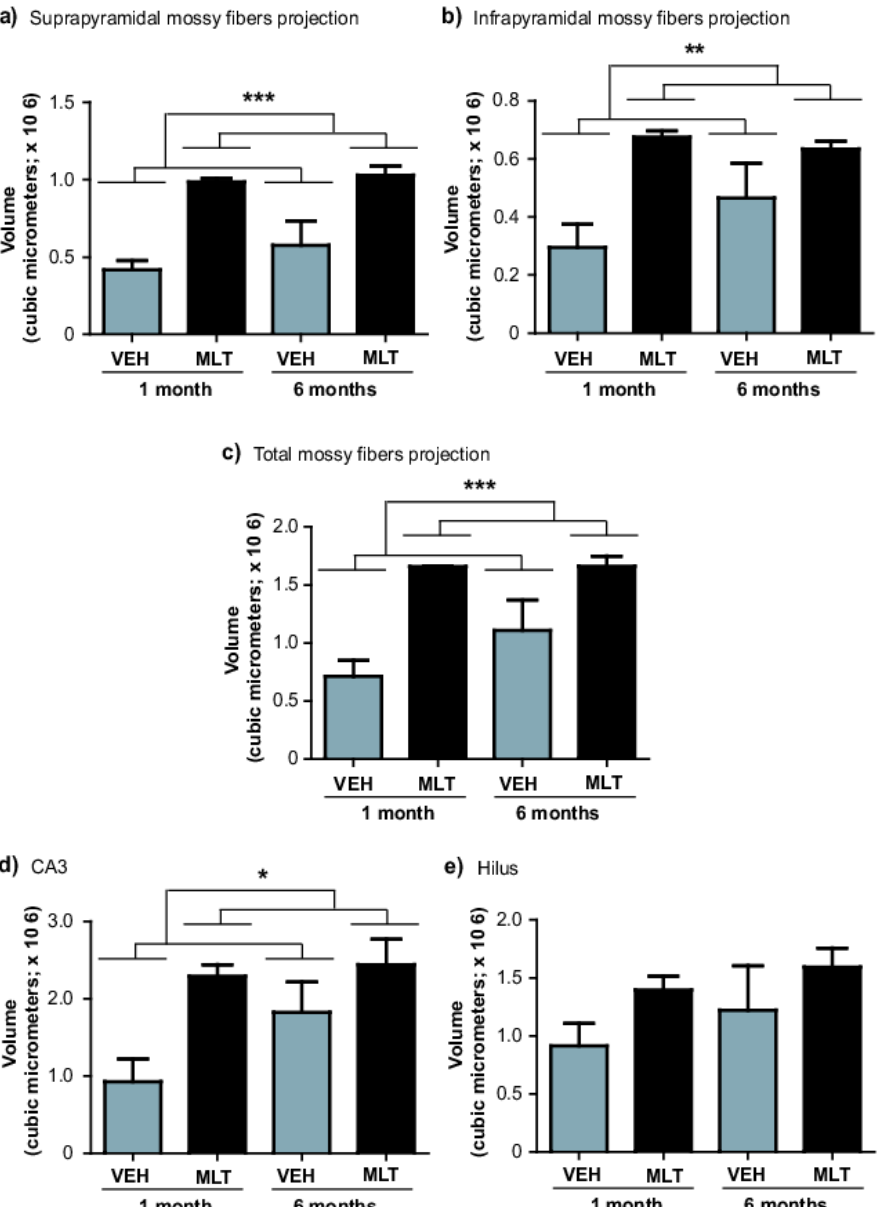
Figure 5. Volumes of mossy fiber tracts were increased by melatonin in male Balb/C mice. ( a ) Volume determination in the suprapyramidal mossy fiber projection indicates that melatonin significantly increased the volume in this subfield of the mossy fibers in the dentate gyrus. Error bars represent S.E.M. *** p < 0.0001. ( b ) Volume in the infrapyramidal mossy fiber projection indicates that one-month of treatment with melatonin significantly increased the volume in this subfield of the mossy fiber in the dentate gyrus compared to the vehicle (VEH). Error bars represent S.E.M. ** p = 0.002. ( c ) However, the total volume of the mossy fiber projection was significantly increased by melatonin in both time points. Error bars represent S.E.M. *** p < 0.0001. ( d ) Moreover, volume determination in the Cornu Ammonis 3 (CA3) region of the hippocampus shows that one-month of treatment with melatonin significantly increased the volume in this subfield of the hippocampus. Error bars represent S.E.M. * p = 0.028. ( e ) Finally, volume in the hilus was not significantly modified by melatonin. Error bars represent S.E.M. In all cases, a two-way ANOVA followed by Student Newman Keuls post hoc test was applied. Asterisks correspond to the main effect of